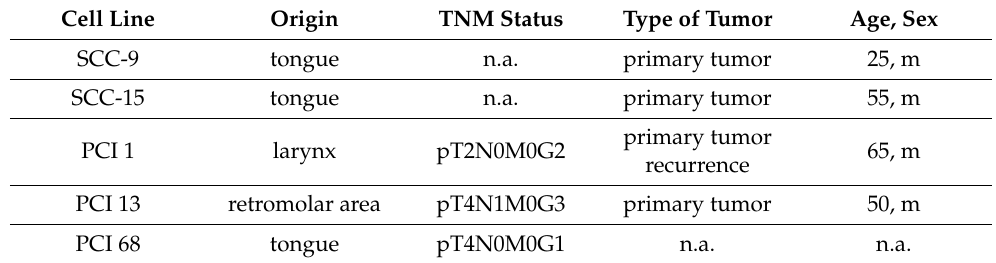
Table 1. Tumor cell line origin, m = male, n.a. = not available. Cell